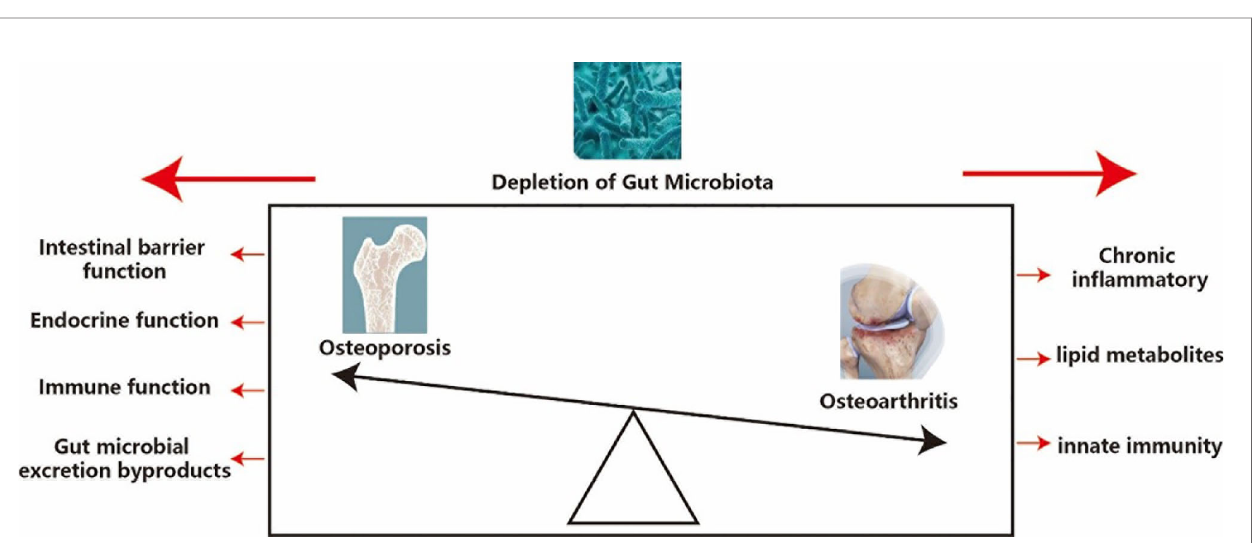
FIGURE 1 | Potential mechanism of depletion of gut microbiota in osteoporosis and osteoarthritis. Osteoporosis and osteoarthritis are like the front and back sides of a coin, and depletion of gut microbiota has a signi fi cant impact on both osteoporosis and osteoarthritis, so it is important to analysis the effect of depletion of gut microbiota on osteoporosis and